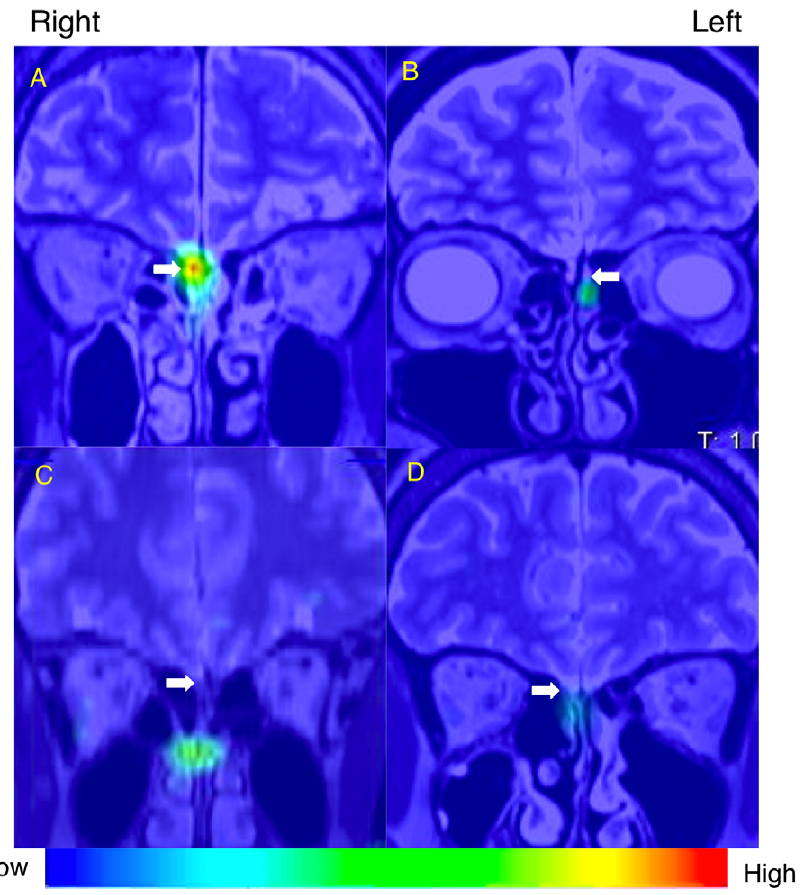
Figure 2. SPECT-MRI fusion image (coronal view) of nasal 201 Tl migration to the olfactory bulb. White arrows indicate the olfactory bulb and olfactory nerve. (A) A 60-year-old healthy male volunteer. (B) A 44-year-old female with hyposmia after head trauma. (C) A 42-year-old female with hyposmia after upper respiratory tract infection. (D) A 67-year-old female with hyposmia due to chronic rhinosinusitis. The index of 201 Tl migration from the olfactory epithelium to the olfactory bulb in the selected subjects was shown in Table 2.